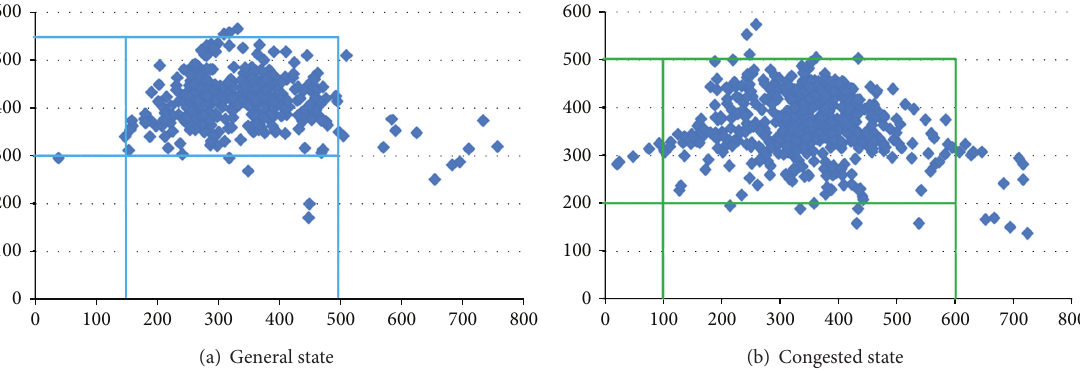
Figure 4: Planar distribution characteristics of driver’s fixation